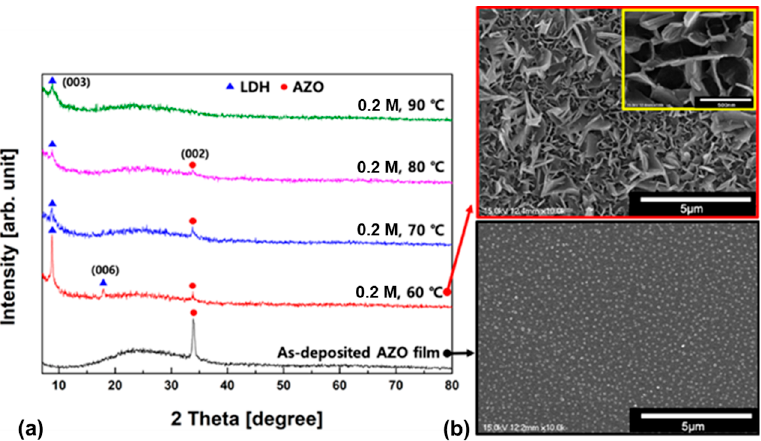
Figure 4. ( a ) XRD patterns of the samples with various heating temperatures, ( b ) surface morphologies of AZO and Zn ‐ Al layered double hydroxides (LDHs).